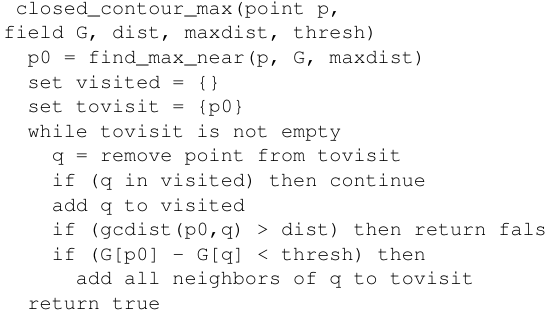
Algorithm 7 Determine all feature paths S , given array of